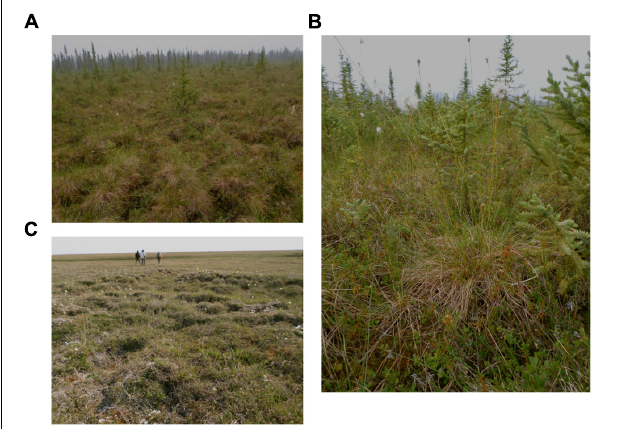
FIGURE 2 | Images showing (A) the habitat of the Coldfoot sampling location south of treeline, (B) a mature Eriophorum vaginatum tussock at Coldfoot, and (C) the habitat of the Prudhoe Bay sampling location in north central Alaska. All photos by E.